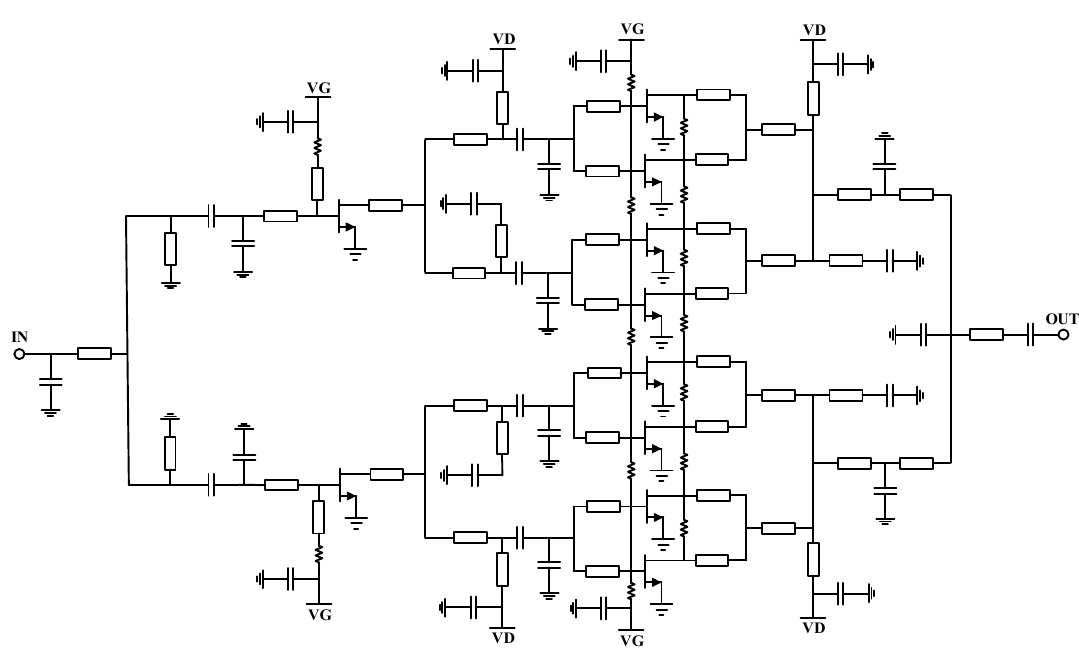
Figure 4. The circuit topology of the power amplifier.